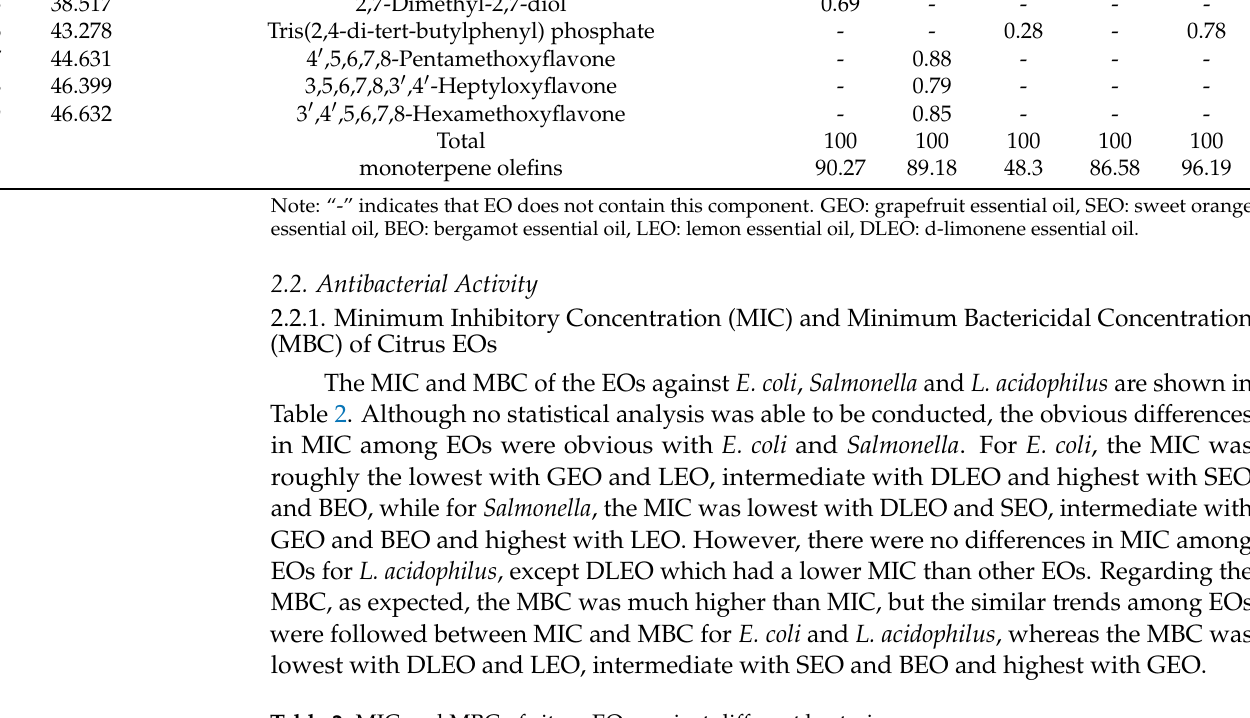
Table 2. MIC and MBC of citrus EOs against different